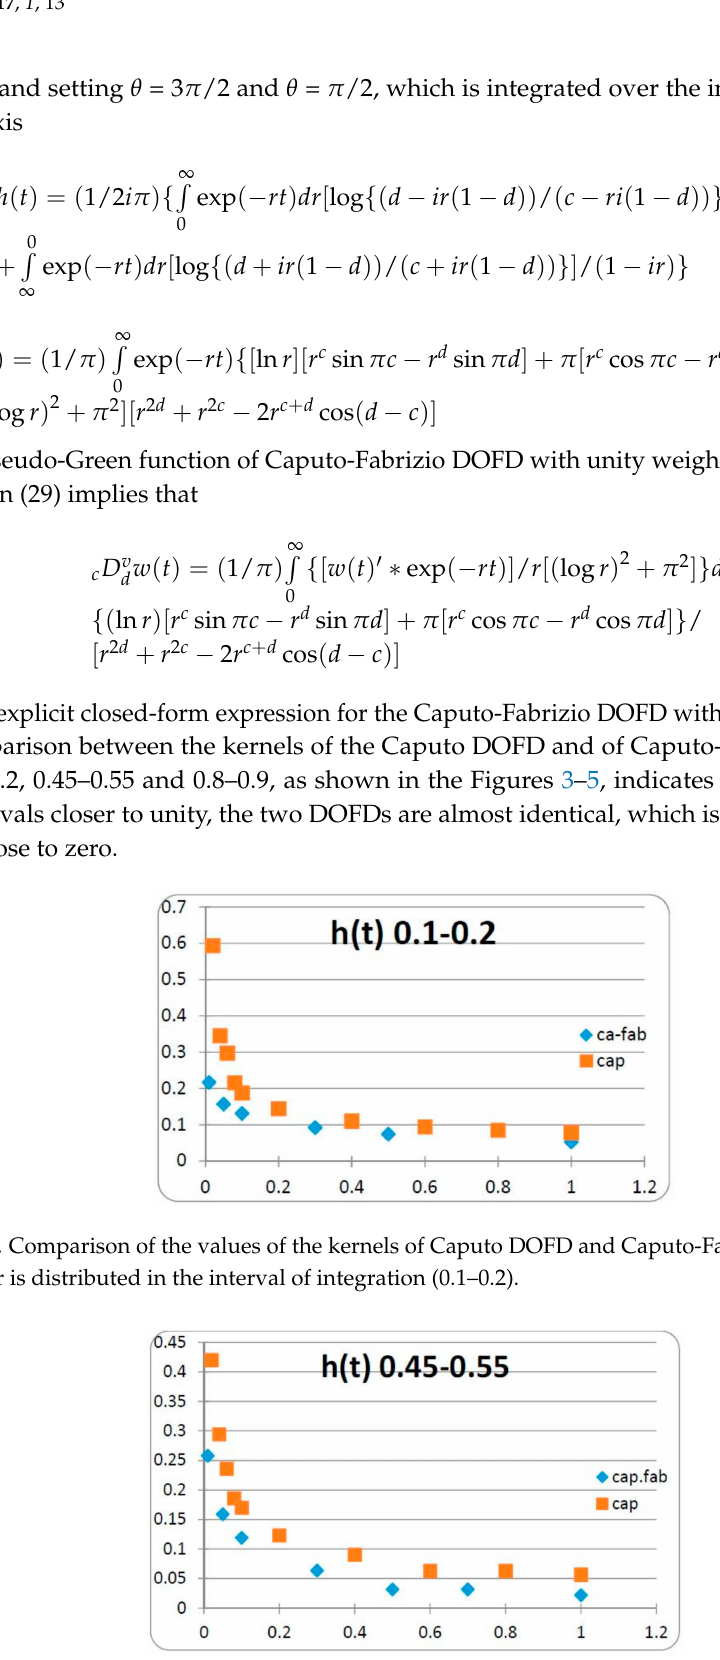
Figure 4. Comparison of the values of the kernels of the Caputo DOFD and the Caputo-Fabrizio DOFD when the order is distributed in the interval of integration